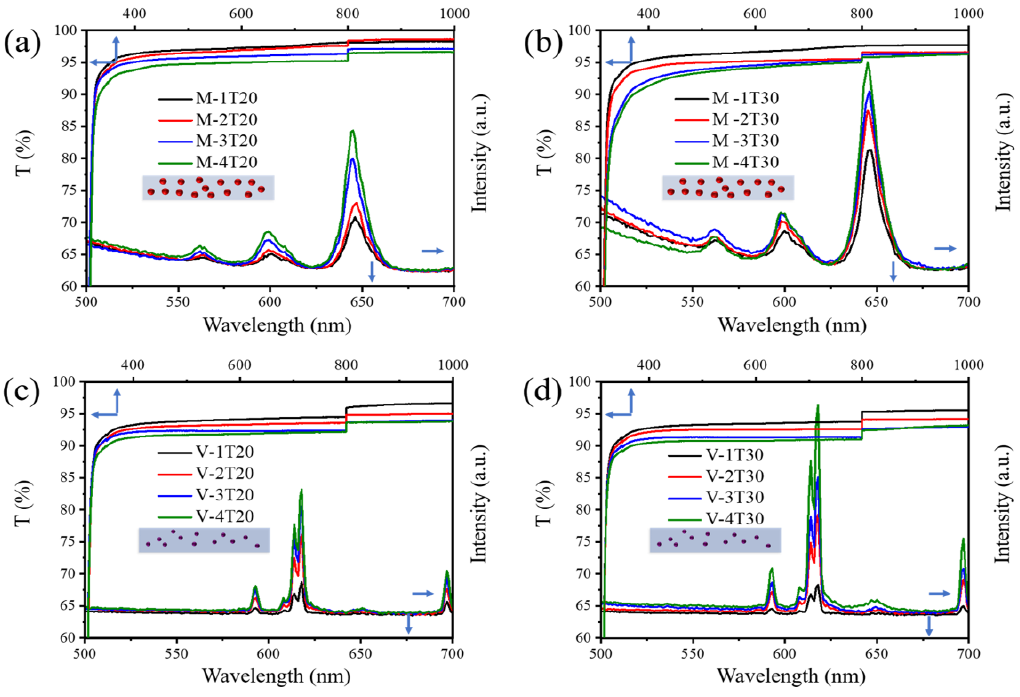
Figure 7. ( a ) Transmission spectra and emission spectra ( λ ex = 408 nm) of M-1T20–M-4T20. ( b ) Transmission spectra and emission spectra ( λ ex = 408 nm) of M-1T30–M-4T30. ( c ) Transmission spectrum and emission spectra ( λ ex = 365 nm) of V-1T20–V-4T20. ( d ) Transmission spectra and emission spectra ( λ ex = 365 nm) of V-1T30–V-4T30. (The blue arrow in the figure points to the coordinate axis corresponding to the curve).